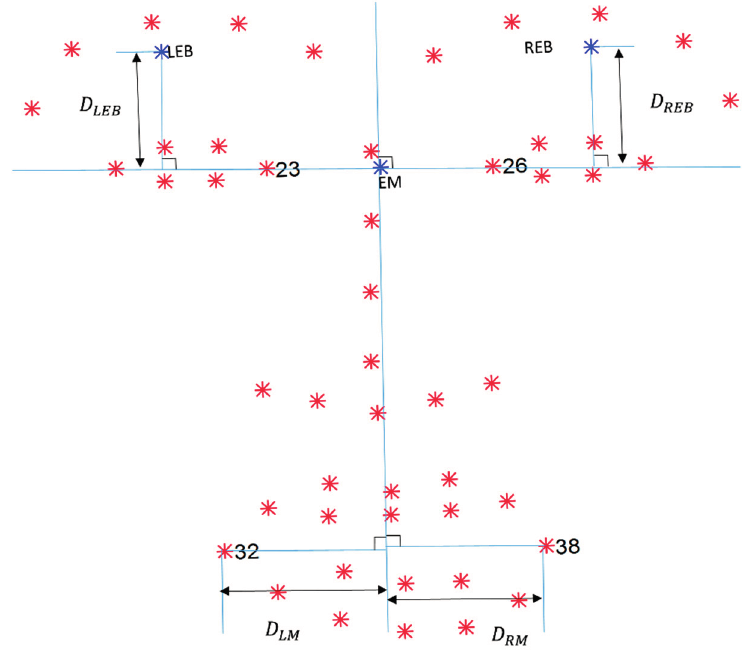
Figure 4. Descriptions of parameters used to calculate asymmetric indices. P represent left and right medial canthus, respectively. Blue horizontal line is drawn by extending connecting line between P vertical line is drawn perpendicular to horizontal line that passes EM. LEB indicates mean point from left eyebrow. REB indicates mean point from right eyebrow. P represent left and right mouth corners, respectively. (cid:1830) and point of intersection. (cid:1830) of